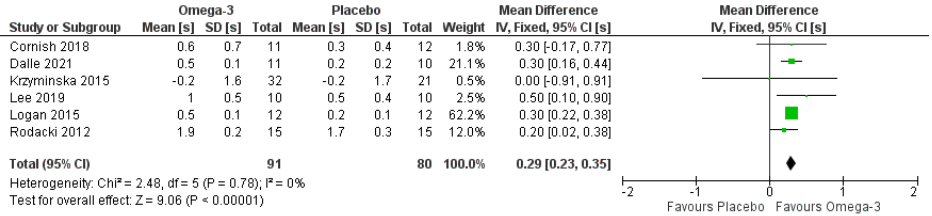
Figure 5. Pooled analysis of the impact of omega-3 supplementation on timed-up-and-go test. Note